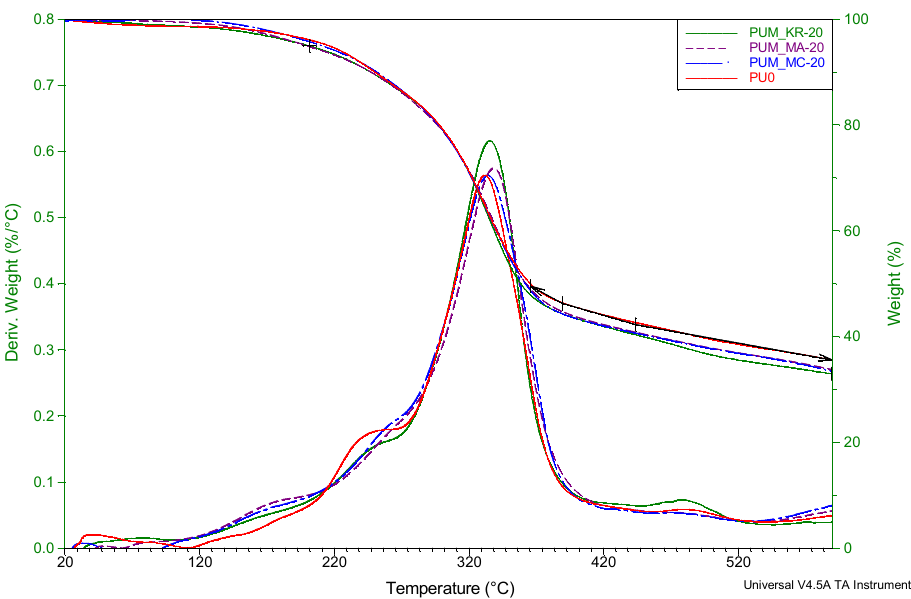
Figure 10. Effect of the different fiber treatments on TG and DTG of the RPUFs.